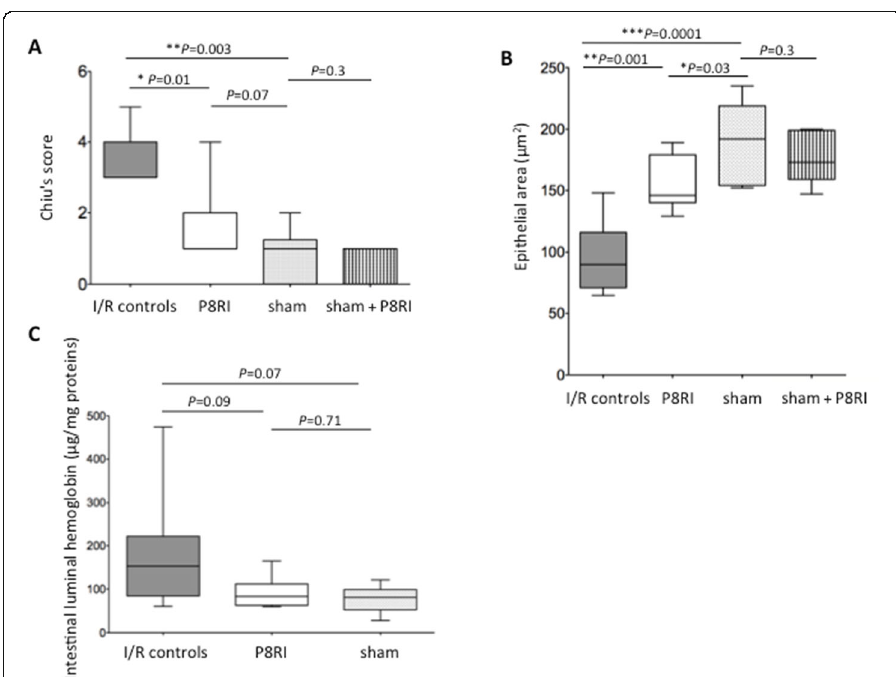
Fig. 1 Effect of P8RI on mesenteric ischemia/reperfusion-induced intestinal injury. Ischemia/reperfusion- induced intestinal injury was assessed by histological analysis using Chiu ’ s score that ranges from a normal mucosa (score = 0) to a total mucosal necrosis (score = 6), and morphometric analysis using Qwin software from scanned histological sections by a nanozoomer in I/R controls, P8RI, and sham groups. a The Chiu ’ s score of intestinal injury was lower in the P8RI group compared to I/R controls (* P = 0.01). b The epithelial area was higher in the P8RI group than in I/R controls (** P = 0.001). c The intestinal luminal hemoglobin concentration only tended to be lower in the P8RI group than in I/R controls, without reaching statistical significance ( P =